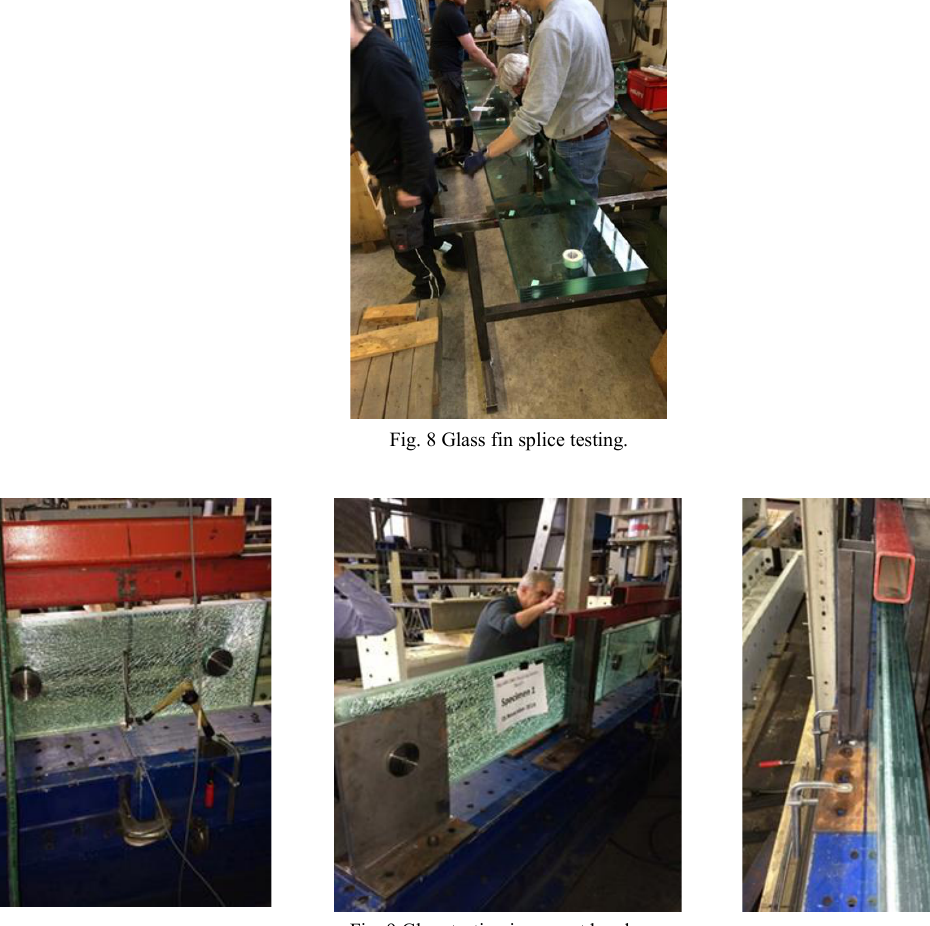
Fig. 9 Glass testing images at